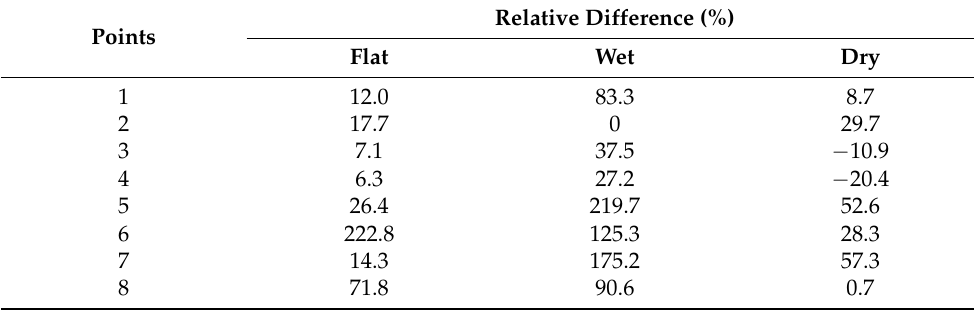
Table 1. Relative difference in TN concentration.